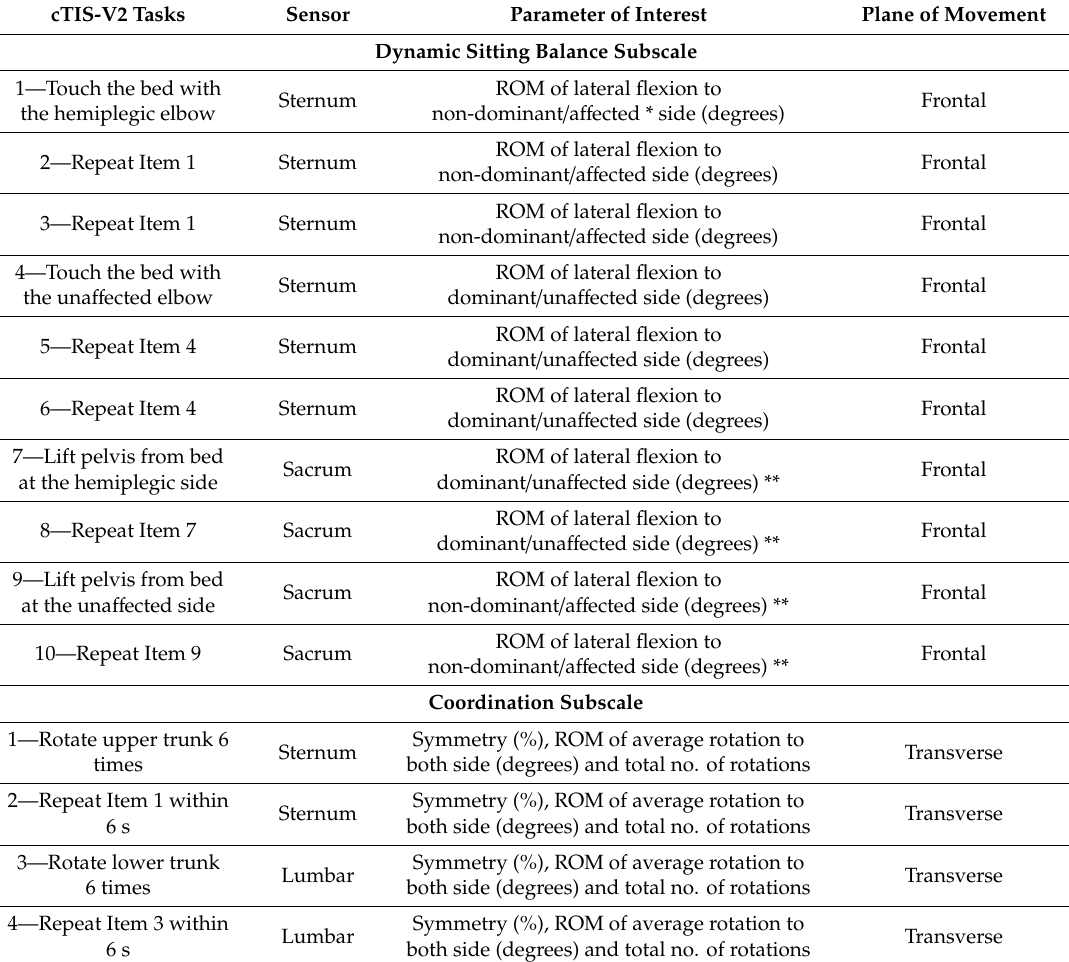
Table 1. Sensor location, plane of movement and parameters of interest for each TIS-V2